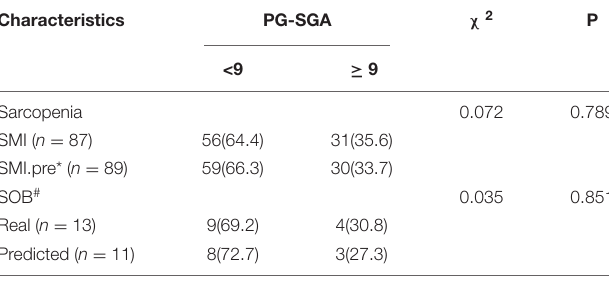
TABLE 3 | The clinical events diagnosed by real measured and predicted parameters and their nutritional